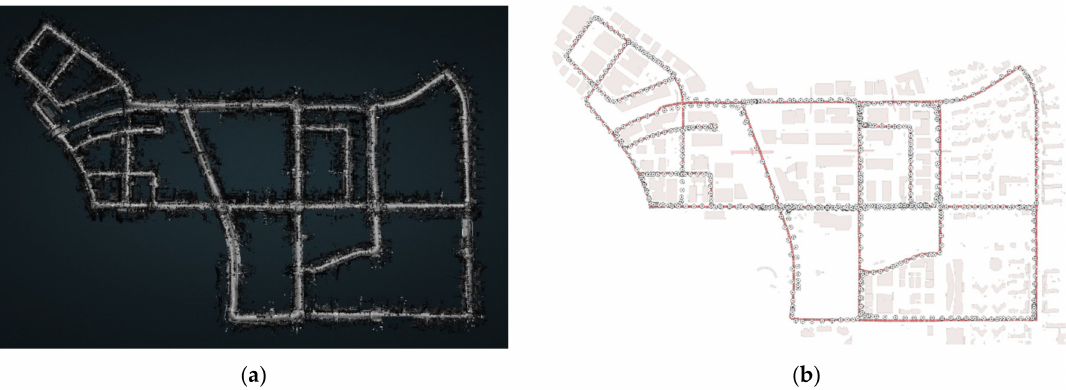
Figure 8. Top view of the test site in Pangyo, South Korea. ( a ) Collected point cloud data [32], ( b ) Distribution of observation